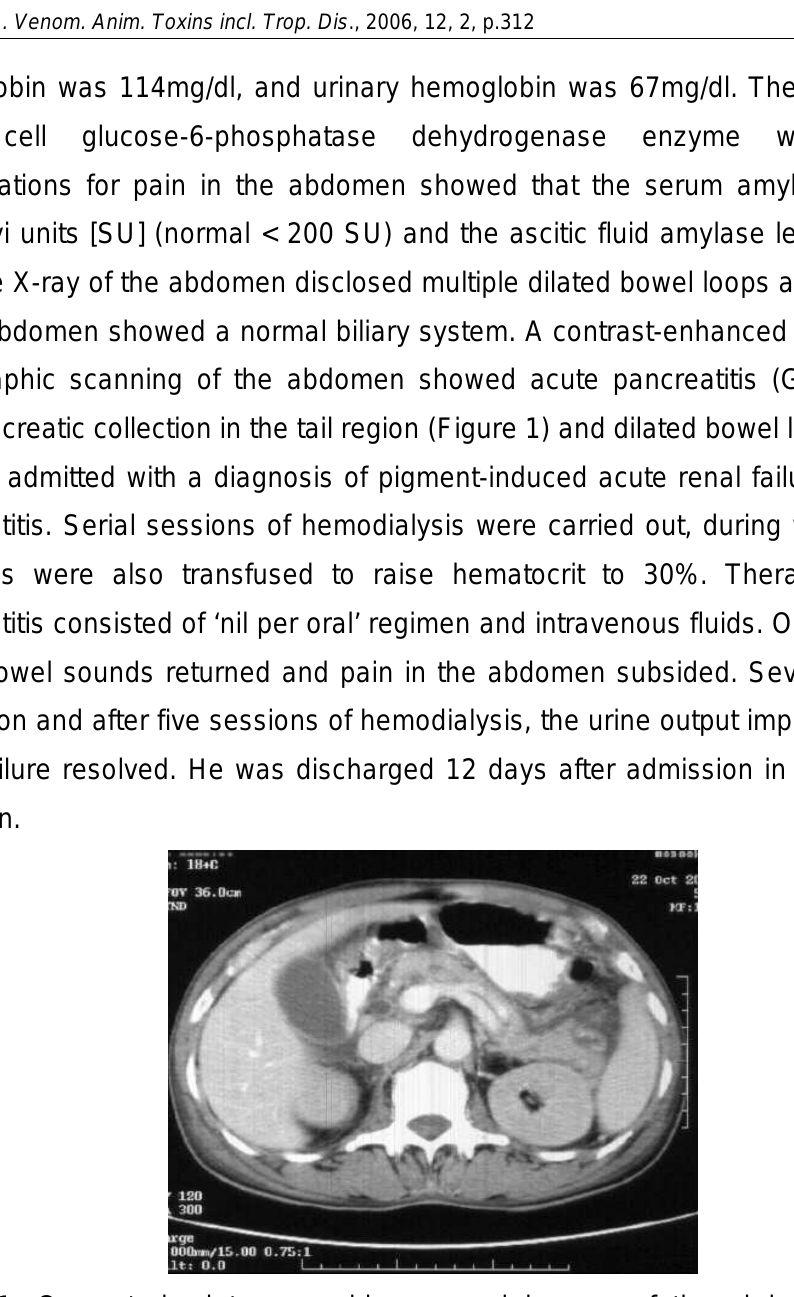
Figure 1: Computerized tomographic scanned images of the abdomen showing dilated bowel loops, a bulky pancreas, loss of peri-pancreatic fat planes and stranding in the tail